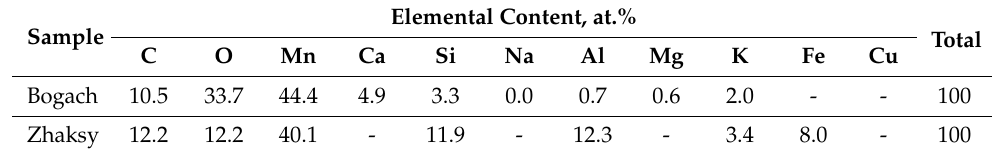
Table 3. Normalized distribution of the content of atoms of elements (at.%).